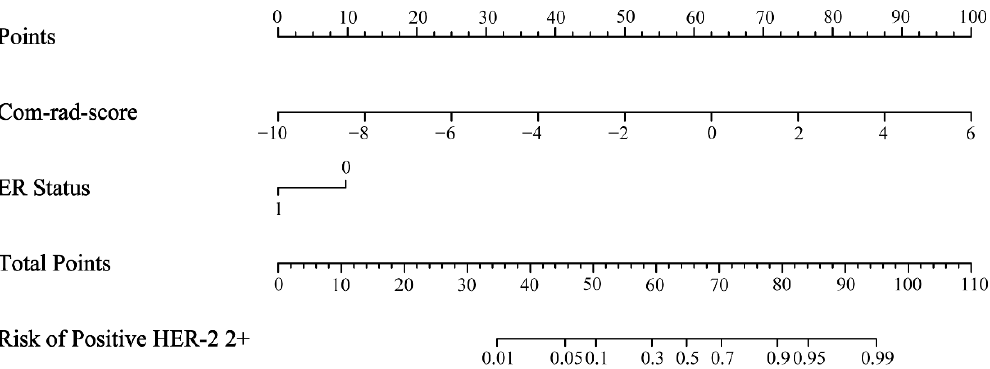
OR, odds ratio; CI, confidence internal. * p < 0.05 was considered statistically significant in the univariate logistic regression analysis. Then, those significant parameters were incorporated into the multivariate logistic regression analysis. Finally, the parameters with p < 0.05 were selected as independent predictors.